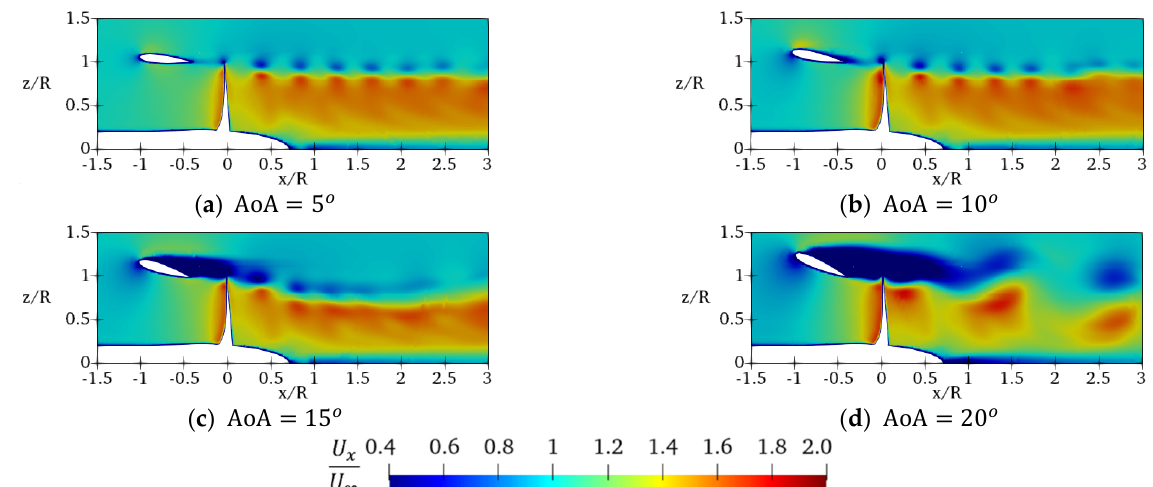
Figure 6. Instantaneous non-dimensional axial velocity contours on longitudinal plane for large duct ( D D = D P